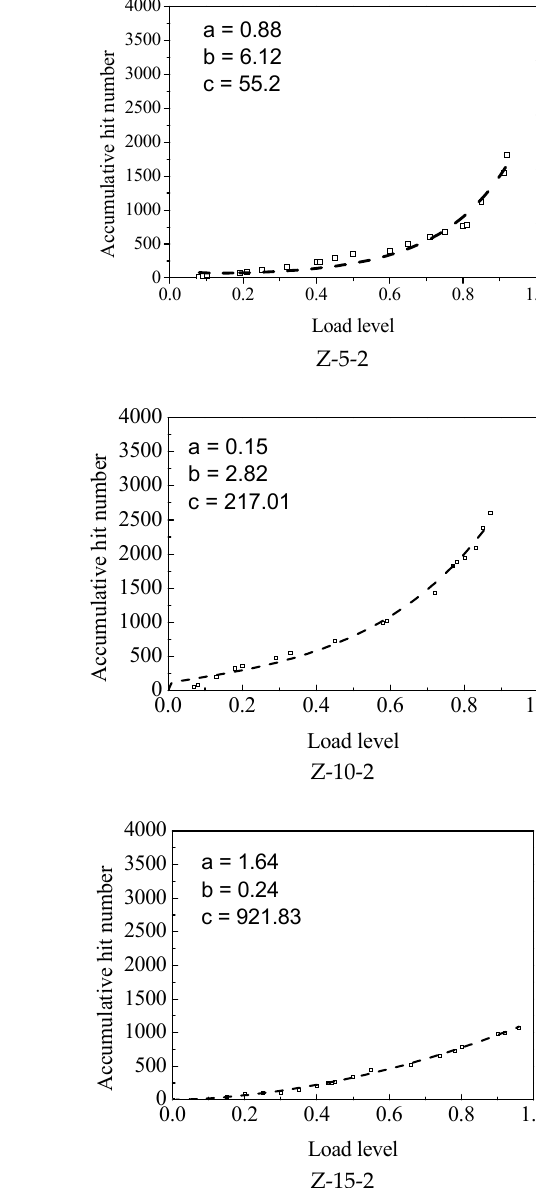
Figure 10. AE events in different corrosion rates and N–V fitting curves. It can be seen that the values of the uncorroded column are − 0.15 and − 0.86, which indicates that the AE rate of the specimens is very low at the lower load level. The initial microcracks of the two uncorroded columns are very few. The values of specimens at a 5% corrosion rate are − 0.06 and 0.88. The AE rate increased with the increase of the corro- sion rate, indicating that the number of microcracks also increased. The values of a for specimens at a 10% and 15% corrosion rate are both greater than 0, and the microcracks propagated. Therefore, comparing the results of the AE rate process theory theoretically proves that the different reinforcement corrosion degrees cause different initial damage to RC columns before axial compression. As a result, the diversity in the internal damage evolution of the corroded column obtained by Equation (10) is verified.